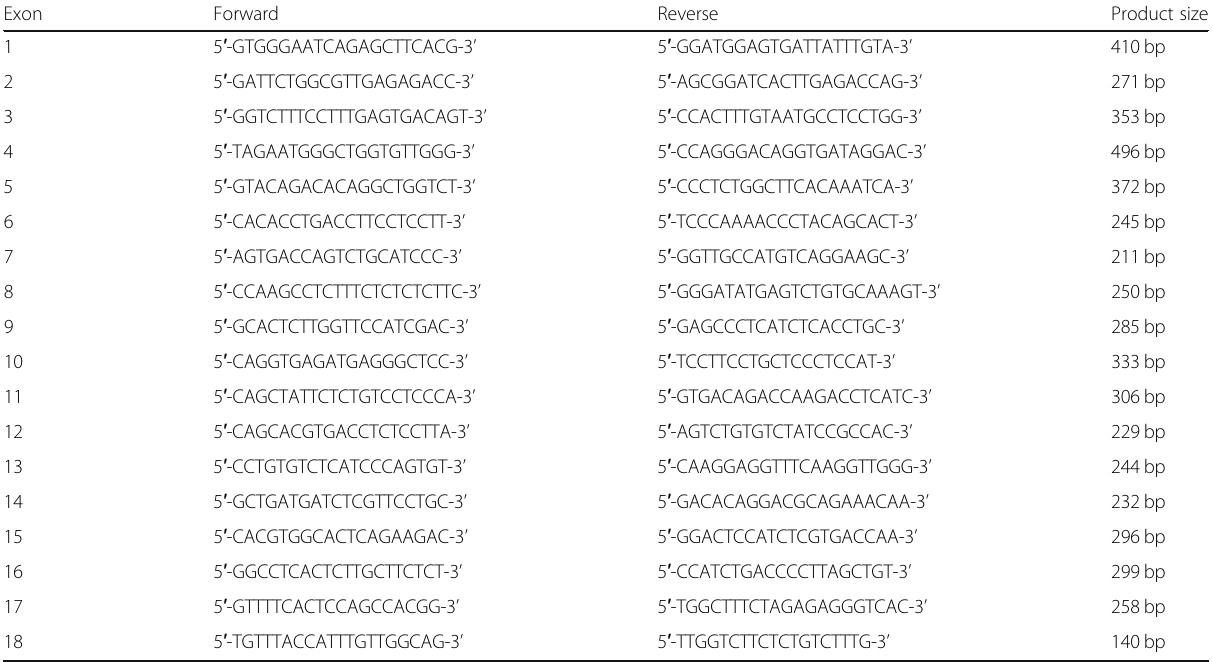
Table 1 PCR primers for amplifications of all coding exons of LDL-R Exon